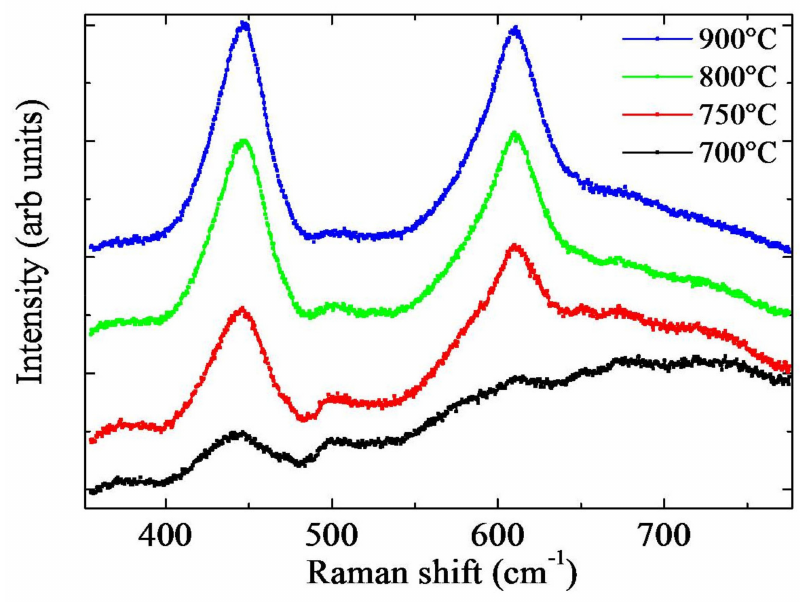
Figure 4. Raman spectra of TiO 2 NWs annealed at different temperatures for 4